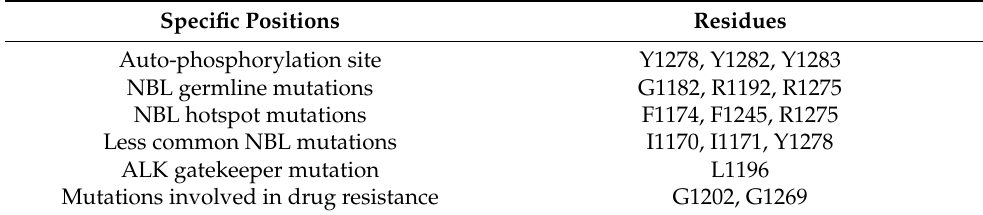
Figure 1. Schematic overview of the ALK protein. In the upper part of the figure, the extracellular domain, the transmembrane segment and the intracellular domain are shown. In the lower part, the kinase domain is enlarged showing the positions of the point mutations described in the text. Table 1. Important ALK point mutations that are described in the text. The gatekeeper mutation and the mutations associated with drug resistance, both towards specific inhibitors and conventional chemotherapy, are uncommon in neuroblastoma.